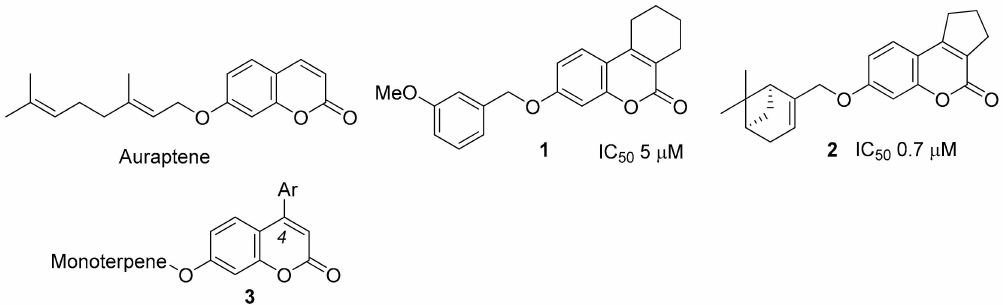
Figure 1. Examples of biologically-active coumarins: auraptene and compounds 1 – 3